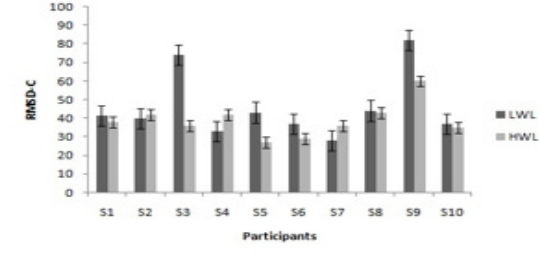
Figure 5. Root means square deviation (RMSD) scores for tracking task